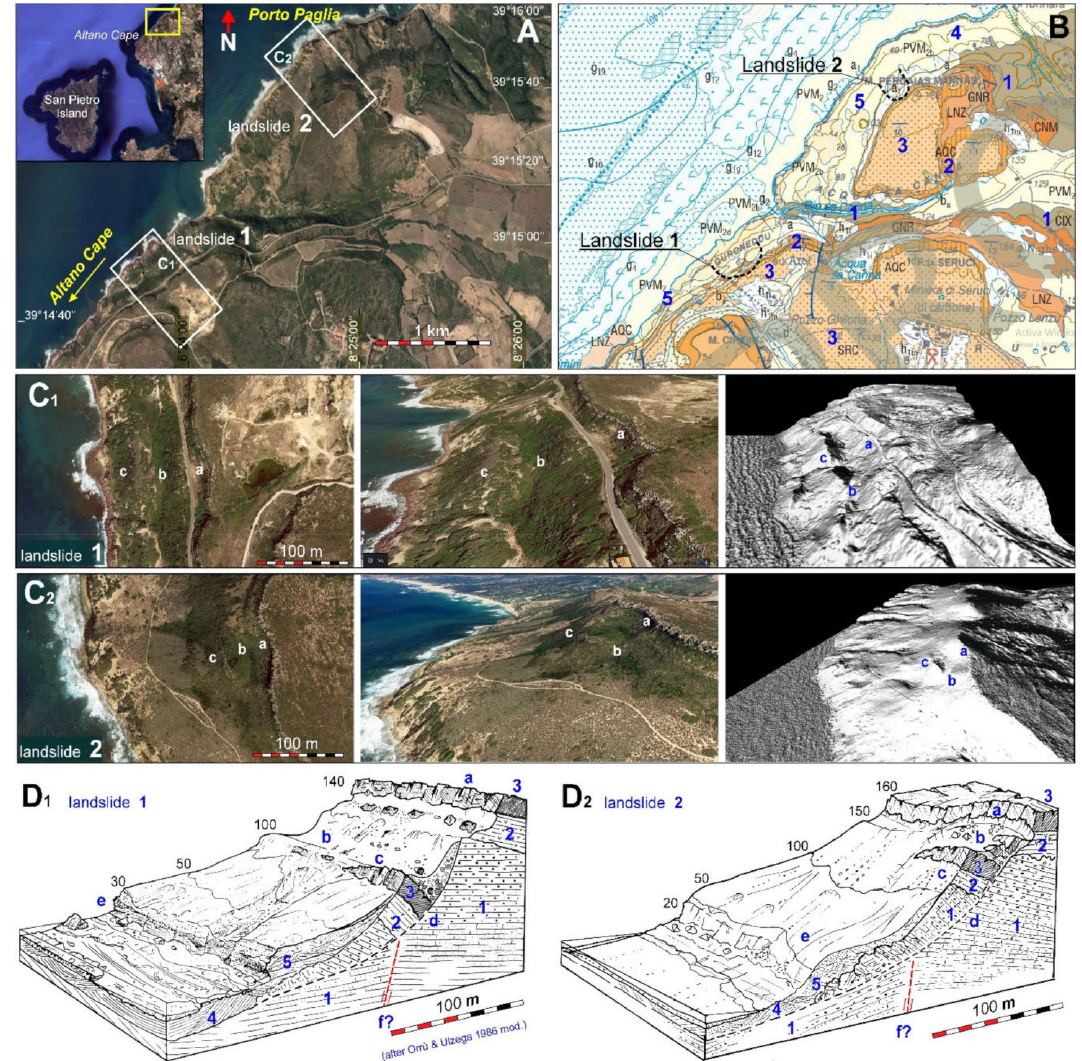
Figure 10. ( A ) Location of the studied coastal palaeo-landslides; ( B ) Excerpt of Geological Map of Italy—scale 1:50,000 Sheet 555 “Iglesias” (Pasci et al., 2015 [33]), with landslides location; ( C ) Aerial photo, photo 3D view and Lidar DTM 3D of landslide 1 ( C 1 ) and landslide 2 ( C 2 ); ( D ) Palaeo-landslide 1 3D interpretive models ( D 1 ) and Palaeo-landslide 2 ( D 2 ), showing rotational kinematics, probably due to the basal erosion during the high-stand MIS 5.5 and the subsequent foot fossilization by continental deposits of the Upper Pleistocene (MIS 4,3,2). Geolithological legend: (1) sandstones and conglomerates, Cixerri Formation—CIX (Eocene-Oligocene); (2) ignimbrites, tuffs—AQC (Middle Miocene); (3) ignimbrites, lavas—SRC (Middle Miocene); (4) eolianites (Upper Pleistocene—MIS 4-3?); (5) eolianites and colluvia—PVM (Upper Pleistocene—MIS2). Morphological legend: (a) detachment niche; (b) trench; (c) counter-slope terrace; (d) rotational sliding surface; (f) cliff engraved in the Pleistocene aeolian deposits that fossilize the landslide